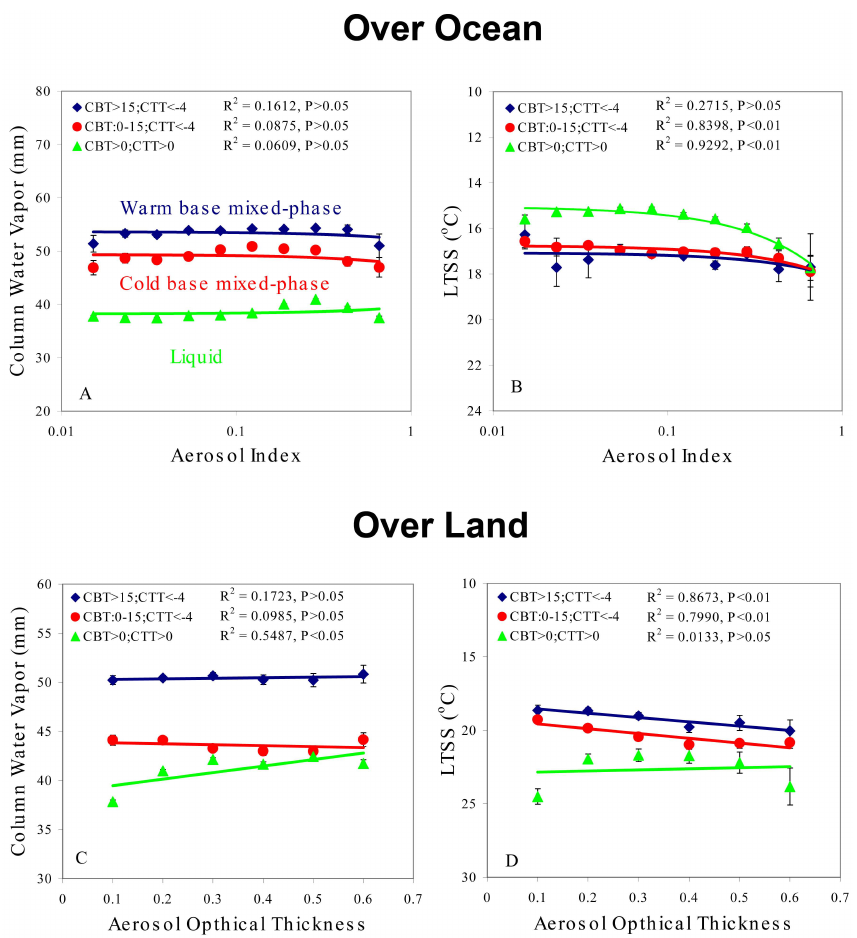
Fig. 4. Column water vapor (A, C) and LTSS (B, D) as a function of AI over the ocean (upper panels) and AOT over land (lower panels) for warm (blue dots) and cold (red dots) base mixed-phase clouds and liquid clouds (green dots). LTSS is plotted in descending order; smaller values (top part of the y-axis) indicate a more unstable